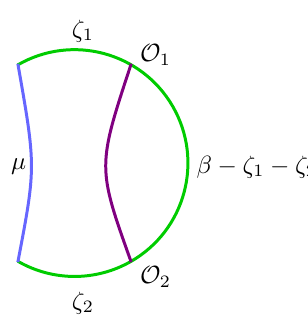
Figure 5 . This figure corresponds to the two-point function of two operators O 1 and O 2 on the Euclidean disk in the presence of an EOW brane. The corresponding wavefunction is given in